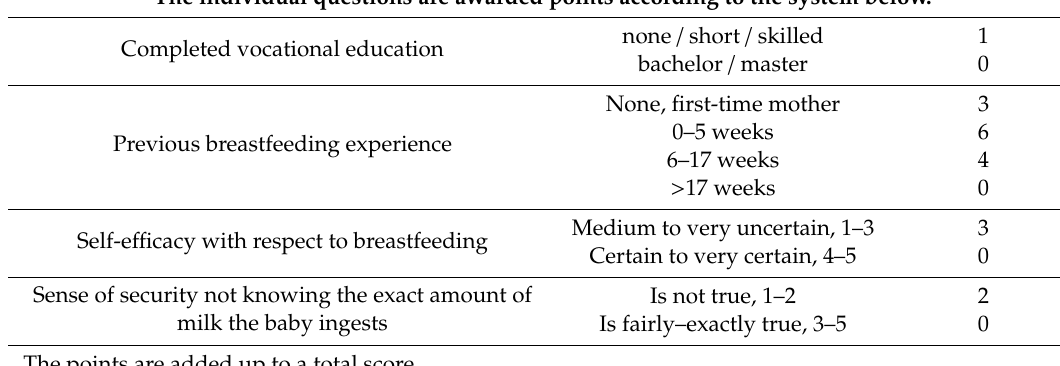
Table 5. Practical application of the breastfeeding score. Key for reading the score. When the mother has completed the questionnaire, her answers are converted into a total score. The individual questions are awarded points according to the system